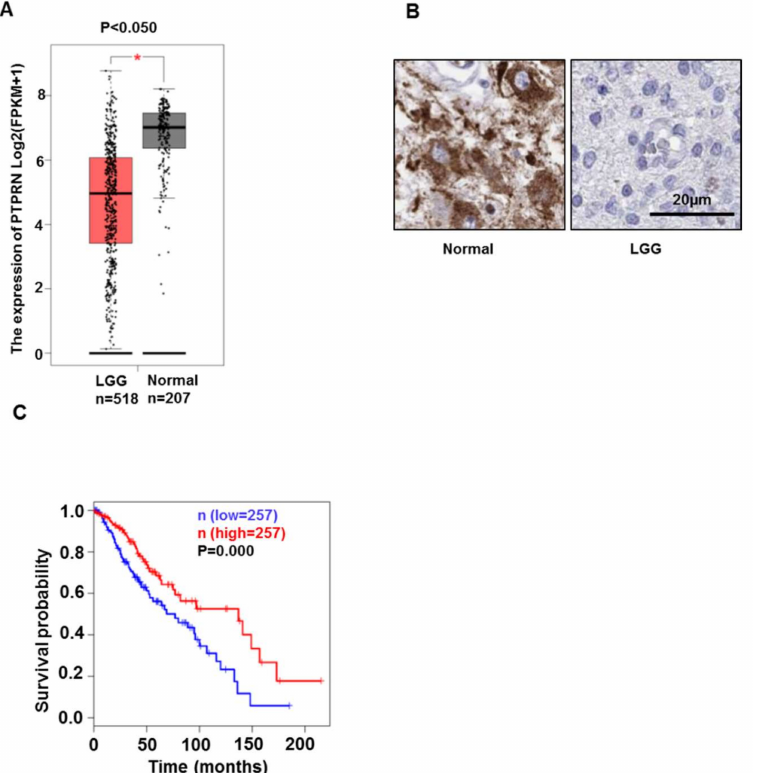
Figure 1. PTPRN mRNA and protein expression between normal and LGG samples, and overall survival in LGG. ( A ) PTPRN mRNA expression is higher in normal brain ( n = 207) than that in LGG ( n = 518) from the Gepia website (http://gepia2.cancer-pku.cn/#analysis, accessed on 9 May 2022). mean ± SD, *: p < 0.050. ( B ) Representative IHC images of PTPRN protein expression in normal brain tissues and glioma tissue (https://www.proteinatlas.org, accessed on 17 February 2022). ( C ) Overall patient survival in groups of high (red) and low (blue) expression was analyzed by Kaplan-Meier survival